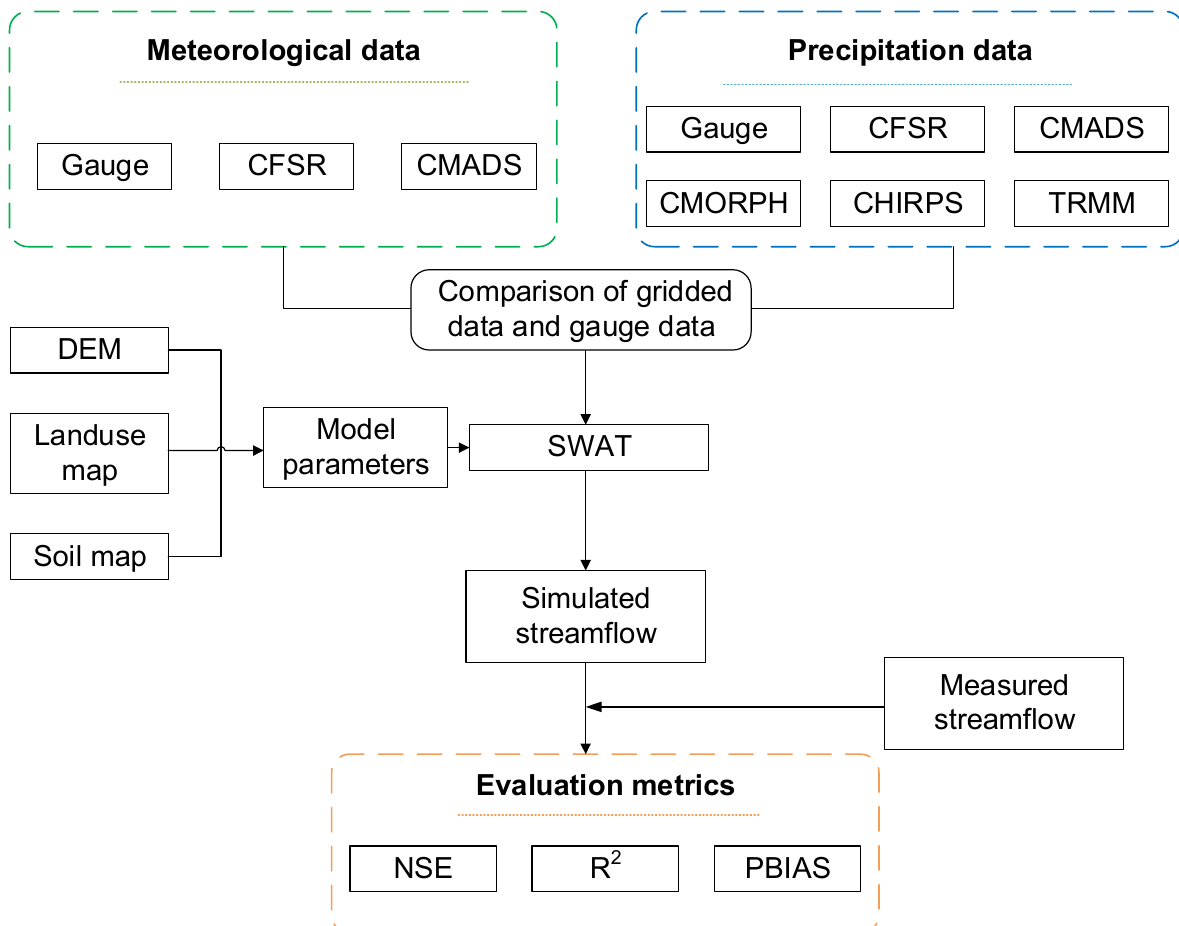
Figure 2. Flowchart of streamflow simulation driven by open-access gridded meteorological and remote sensing precipitation products.